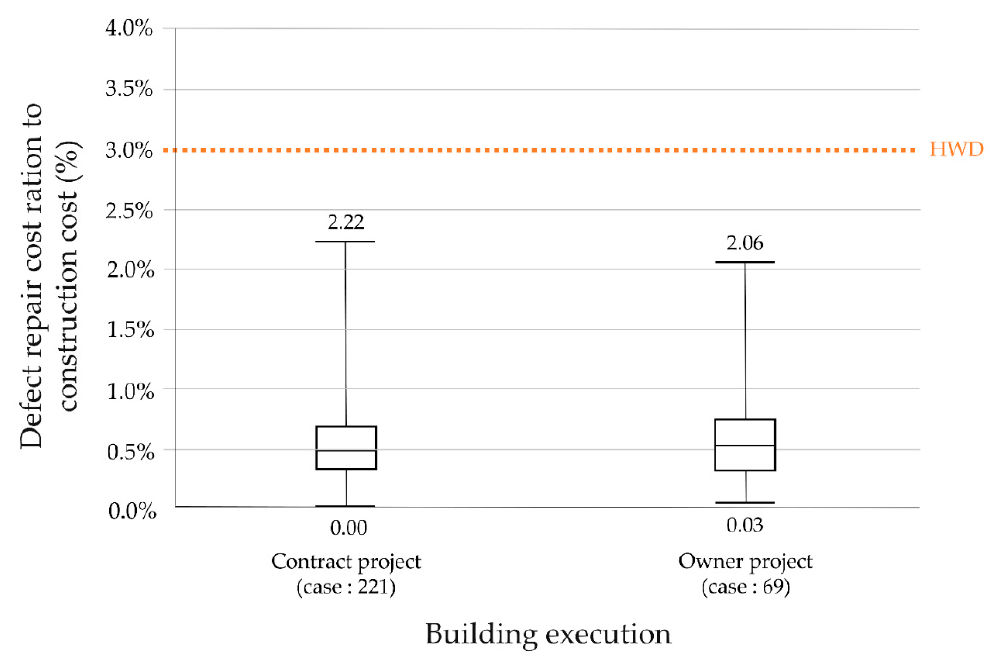
Figure 8. Comparison of building execution.